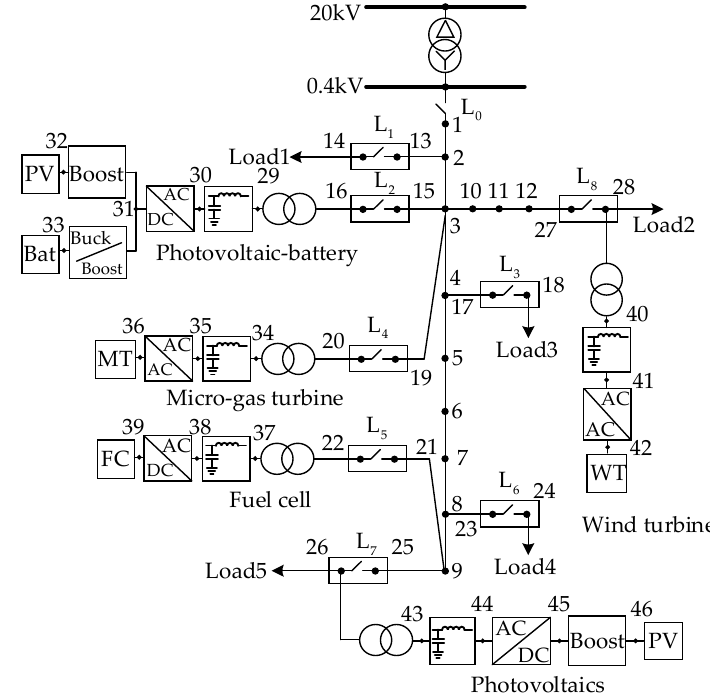
Figure 12. The low-voltage microgrid example.